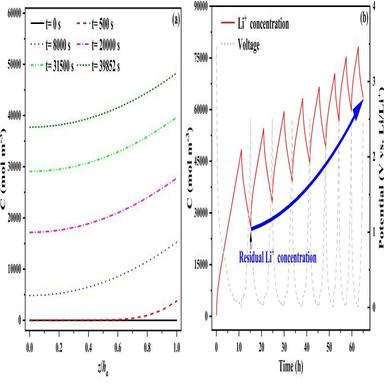
(a) The distribution of lithium-ion concentration at different time during the first discharge process, (b) the evolution of Li+ concentration at the active layer surface during the first 8 cycles.